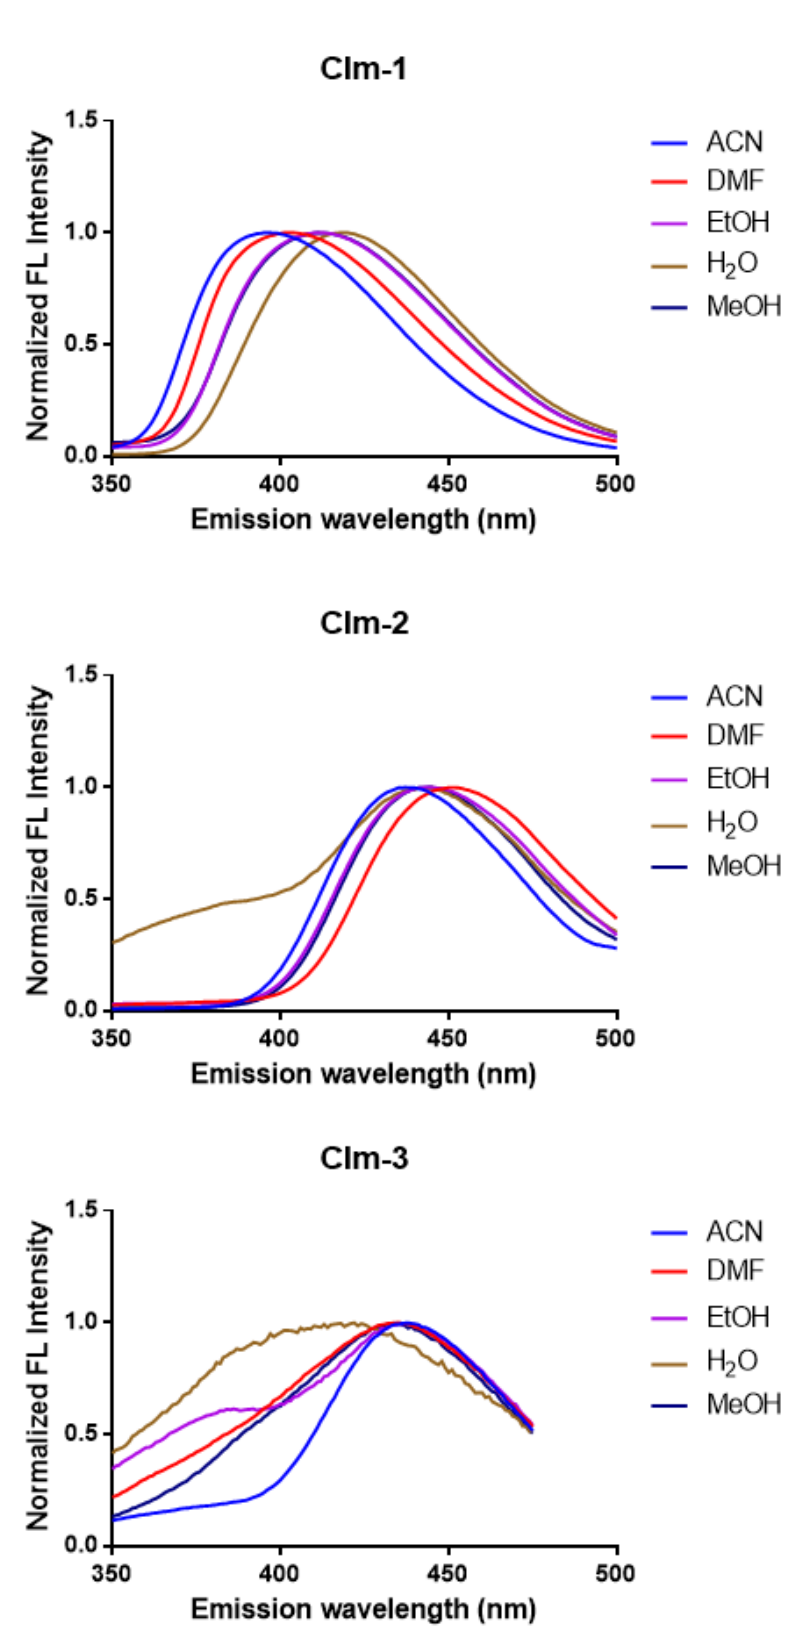
Figure 2. Normalized fluorescence spectra of Clm-1-3 in protic (H 2 O, EtOH, and MeOH) and aprotic (ACN and DMF) solvents, with final concentration of 30 µM for all compounds.